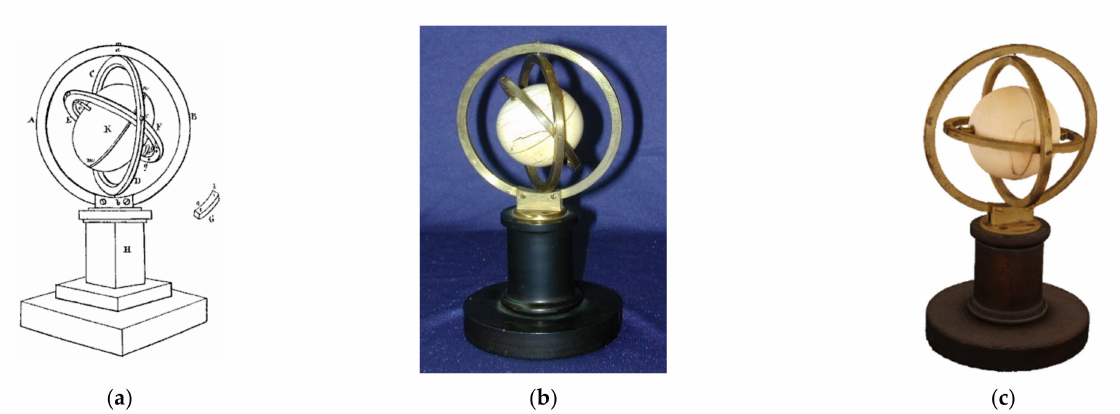
Figure 2. The very first gyroscope of 1810—the Machine of Bohnenberger, Tuebingen, Germany. ( a ) Original drawing; ( b ) Photo; and ( c ) 2.5D digital twin by CV/photogrammetry.